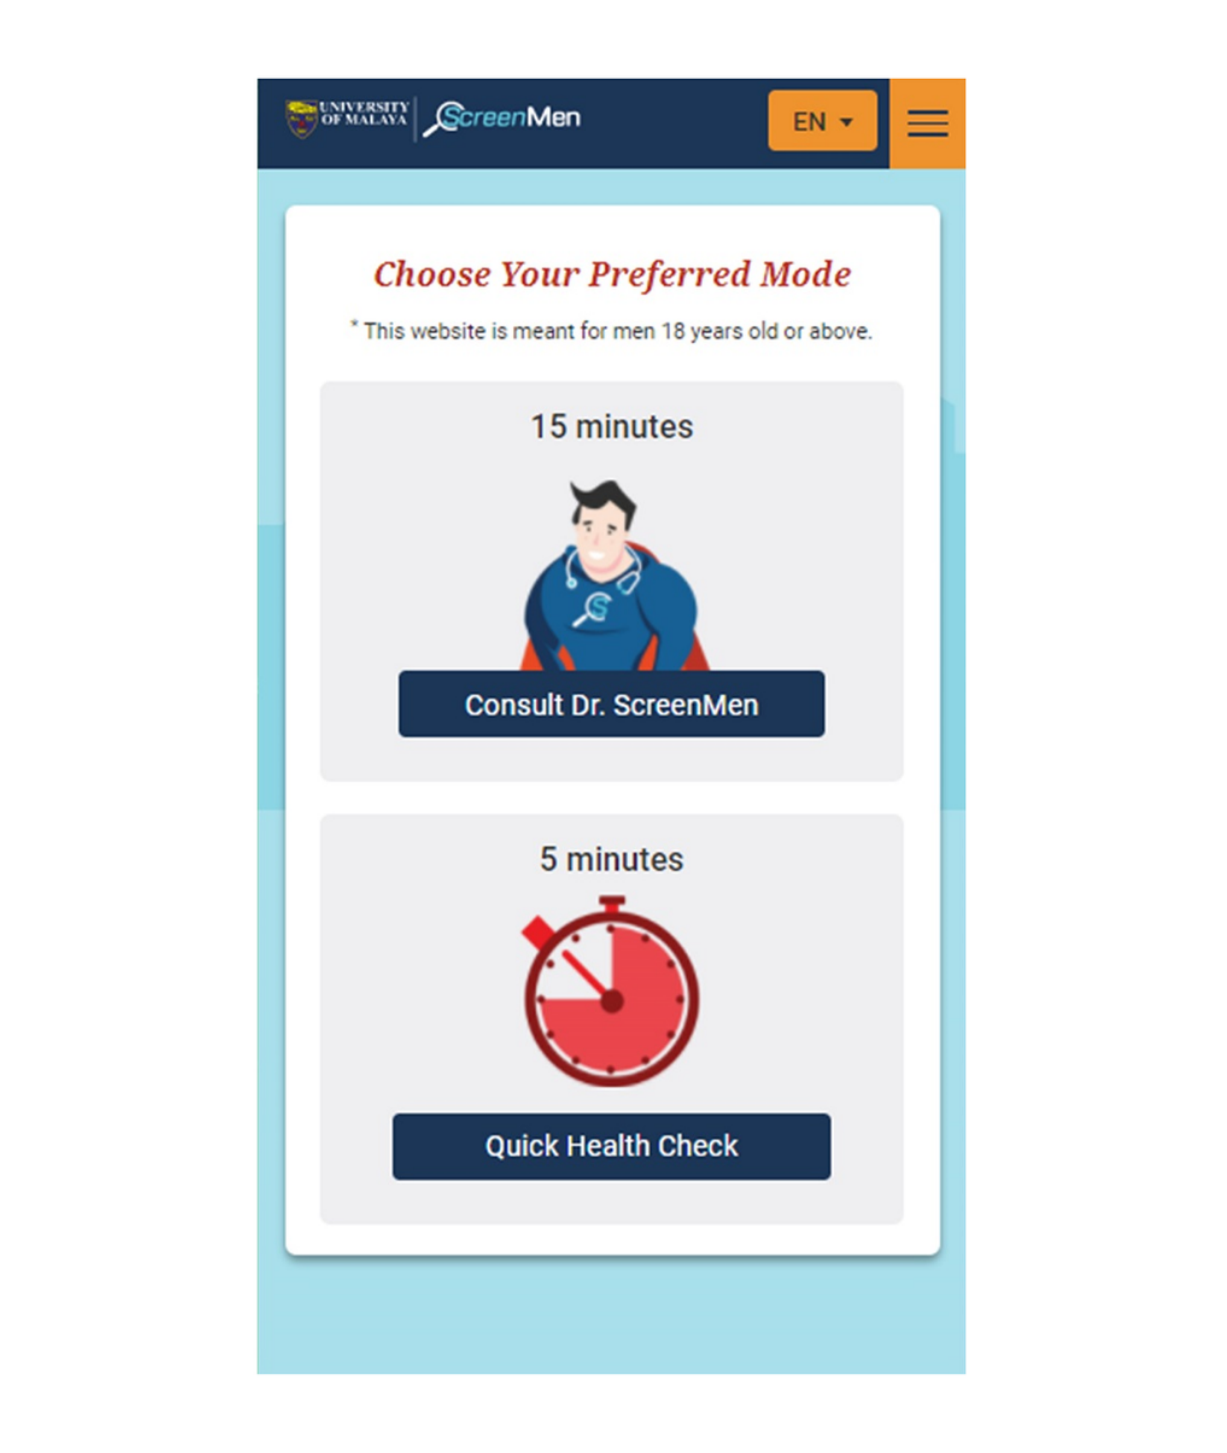
Figure 5. Options of consultation or quick mode for health